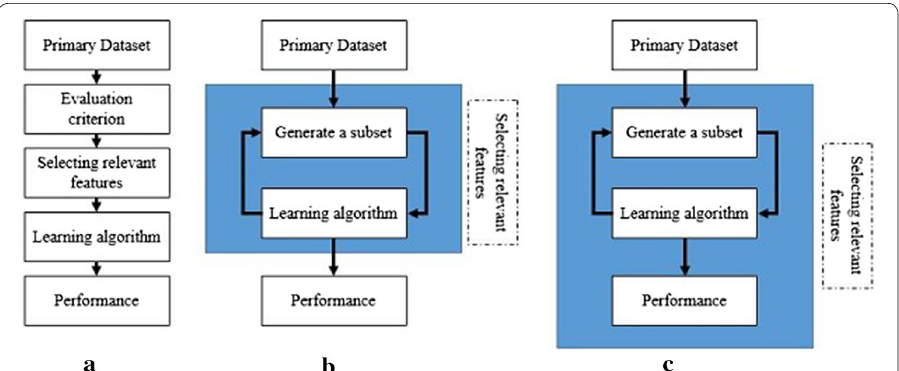
Fig. 1 Basic feature selection methods. The figure shows the three main types of feature selection, filter, wrapper and embedded methods as well as the process in which data passes from initiation to completion of selection in each